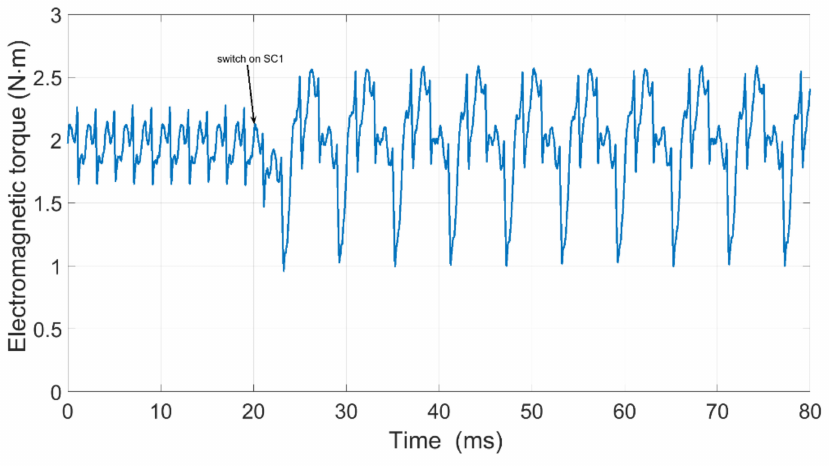
Figure 6. Y configuration-waveforms of electromagnetic torque, healthy to SC1- numerical calculations.